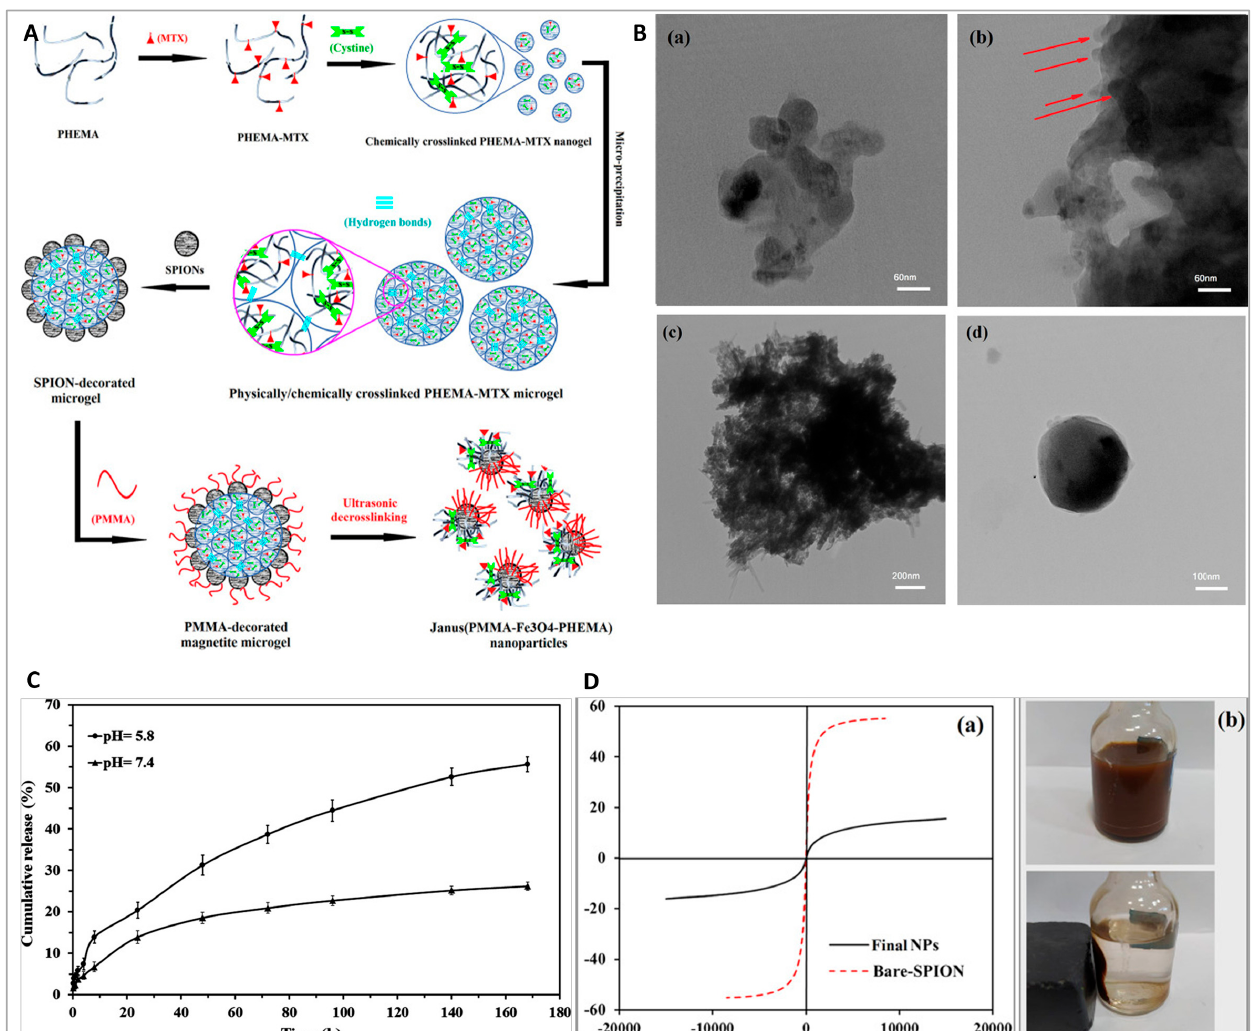
Figure 6. A schematic exhibiting the synthesis procedure of pHEMA-PMMA-magnetite (Fe 3 O 4 ) ( A ); the TEM micrographs of the cross-linked pHEMA nanogel (chemically) ( a ), the cross-linked pHEMA microgel (physically and chemically) ( b ), Fe 3 O 4 - coated cross-linked pHEMA-methotrexate ( c ), pHEMA-PMMA-Fe 3 O 4 (Janus) ( d ) ( B ); the release trends of methotrexate from pHEMA-PMMA-Fe 3 O 4 nanoparticles ( C ); the magnetic hysteresis loops of bare Fe 3 O 4 and final pHEMA-PMMA- Fe 3 O 4 nanoparticles ( a ) plus separation of pHEMA-PMMA-Fe 3 O 4 nanoparticles in water by a magnet ( b ) ( D ). Reprinted from [15], with permission from the American Chemical Society. (Red arrow: in Figure ( b ) show coagulation of cross-linked pHEMA